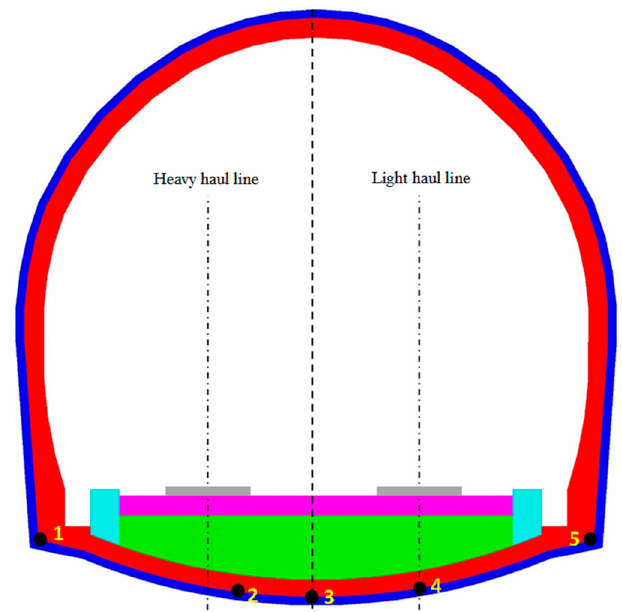
Figure 8. Measuring point layout.